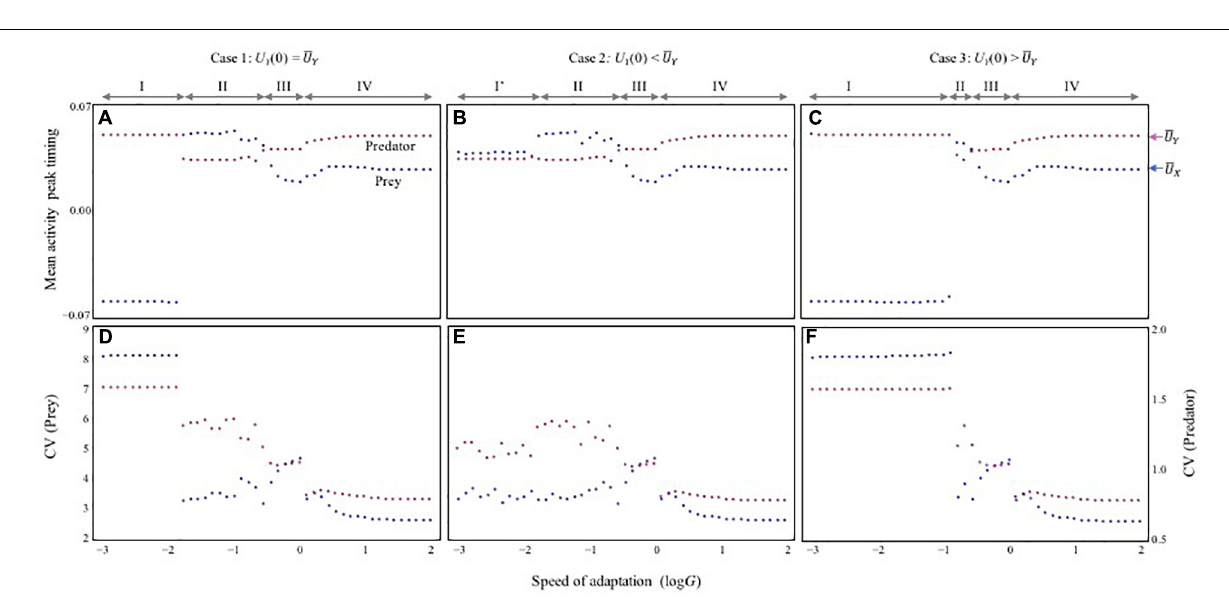
timings, U i (0) = ¯ U i . In this case, very slow adaptation has a